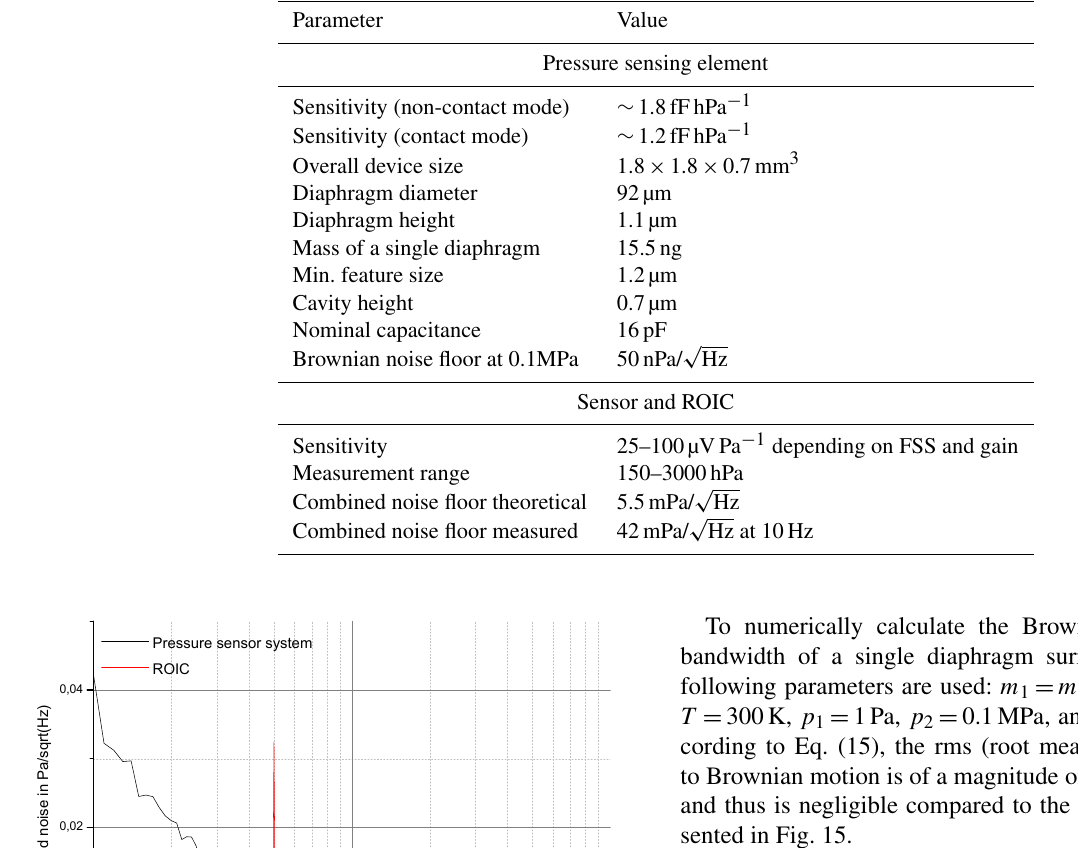
Table 5. Parameters of the pressure sensor.